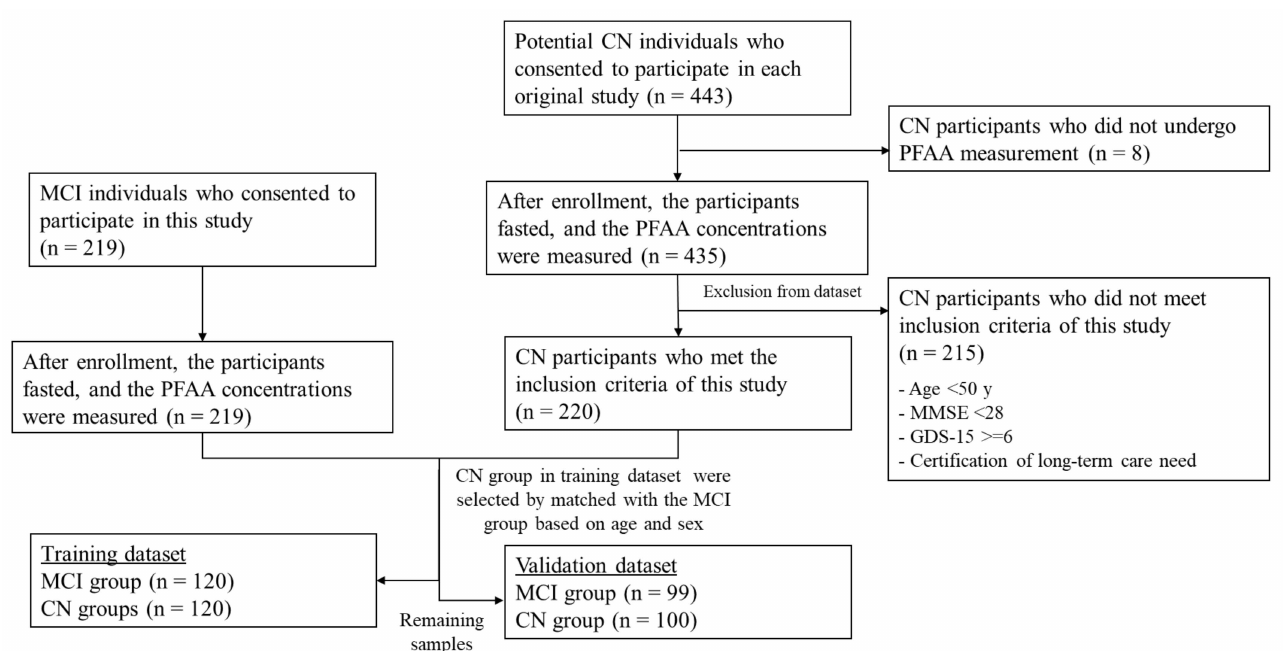
Figure 1. Summary of study